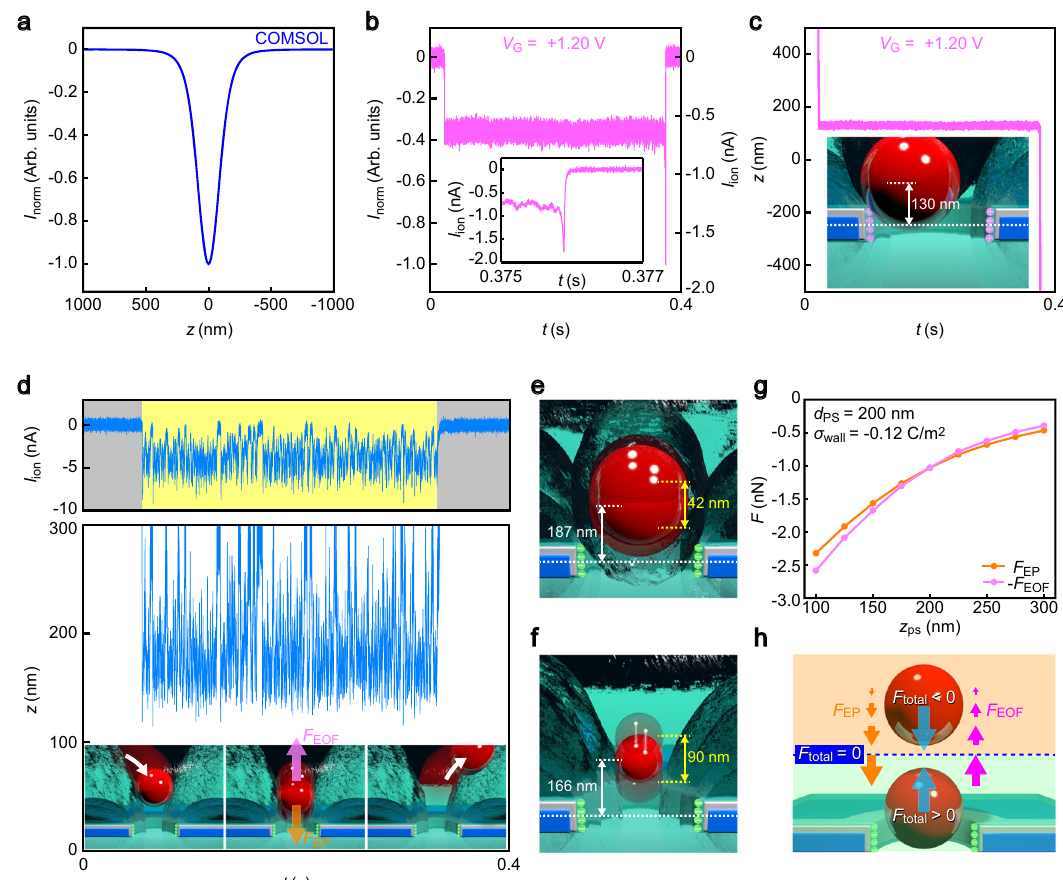
Fig. 5 Vibration modes of single-nanoparticles trapped by a fi eld-effect nanopore. a Finite element analysis of ionic current blockade in the 300 nm-sized surround-gate nanopore by a 200 nm-sized nanoparticle under V b = 0.5 V. z denotes the position of the center-of-mass of the spherical particle with respect to the middle of the nanopore. Open pore current is offset to zero. I norm is the normalized ionic current by the height of the pulse. b A typical I ion signal.at V = − 1.20 V. The inset shows a close view at the end of the signal wherein a sharp drop in the ionic current represents fast translocation of the surface- G adsorbed nanoparticle after desorption. c Motion track of the nanoparticle in b . Inset image illustrates the location of the nanobead adsorbed on the positively-biased nanopore wall surface via the coulomb interactions. d A I ion signal at V G = − 1.05 V and corresponding particle motions. The absence of the sharp edge at the end of the signal indicates repelling of the nanoparticle instead of electrophoretic translocation as depicted in the insets. Illustrative models depicting the motions of the 200 nm- ( e ) and 100-nm-sized nanoparticles ( f ) trapped at the surround-gate nanopore ori fi ce under V G = − 1.05 V. g The electrophoretic ( F EP ) and the electroosmotic drag forces ( F EOF ) on the nanoparticle positioned at z ps . σ wall is the surface charge density at the pore wall. The sign of F EOF is inverted for the sake of clarity. h A schematic illustration describing the force balance at the nanopore ori fi